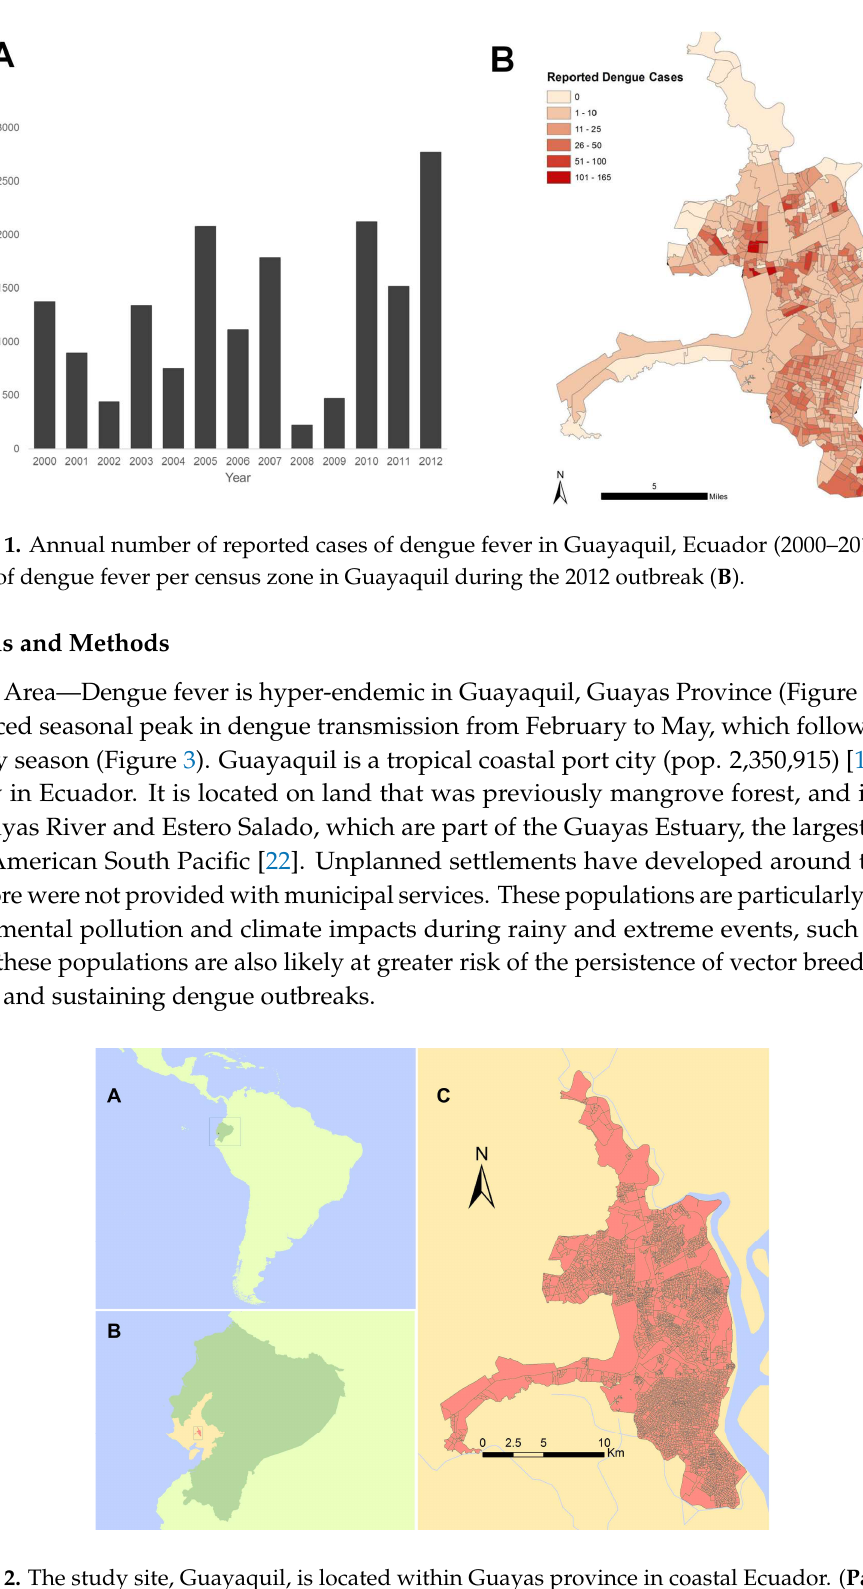
Figure 2. The study site, Guayaquil, is located within Guayas province in coastal Ecuador. ( Panel A ) shows the location of Ecuador (medium green) in S. America (bright green); ( Panel B ) shows the location of Guayaquil (dark orange) within Guayas Province (warm yellow), in Ecuador; ( Panel C ) shows the city of Guayaquil, detailing the census block structural layout, and showing where major and minor waterways exist surrounding the city